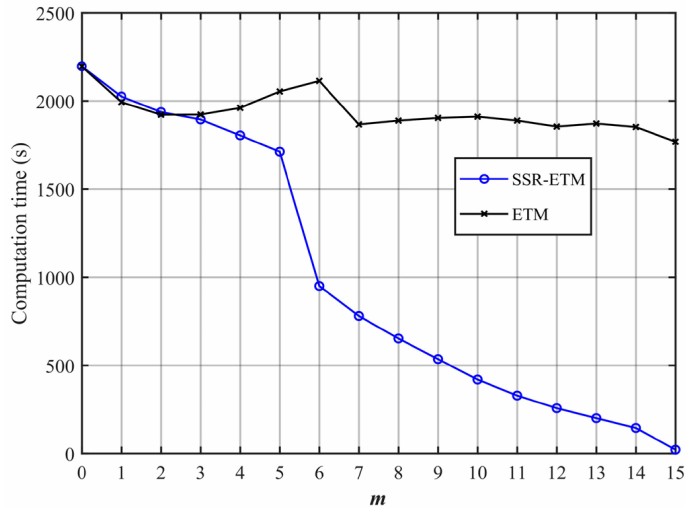
Figure 5. Computation time of the two methods for the 15-dimensional function.